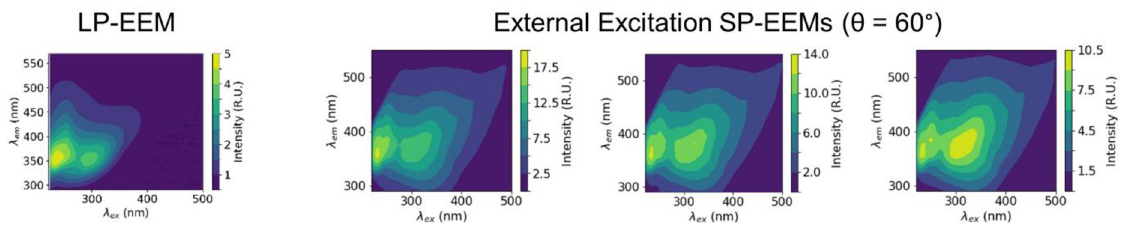
Fig 4. External excitation SP-EEMs for cigarette smoke show that most of the peaks agree with LP-EEM. The removal and interpolation of Rayleigh and Raman scattering lines lead to broadening or removing fluorescence in SP-EEMs compared to LP-EEMs, similar to woodsmoke signatures (Fig